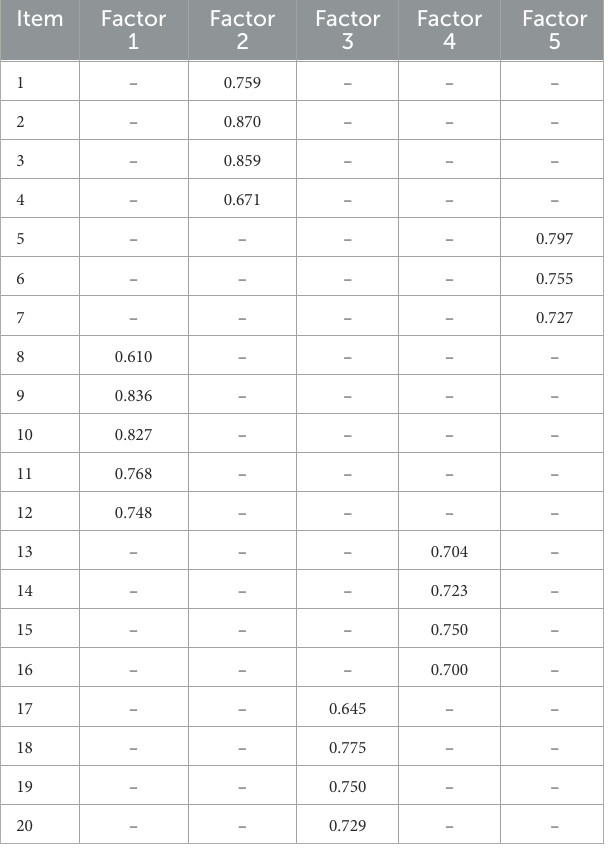
TABLE 5 Fit indices both before and after adjustment for Chinese DoCCA scale.